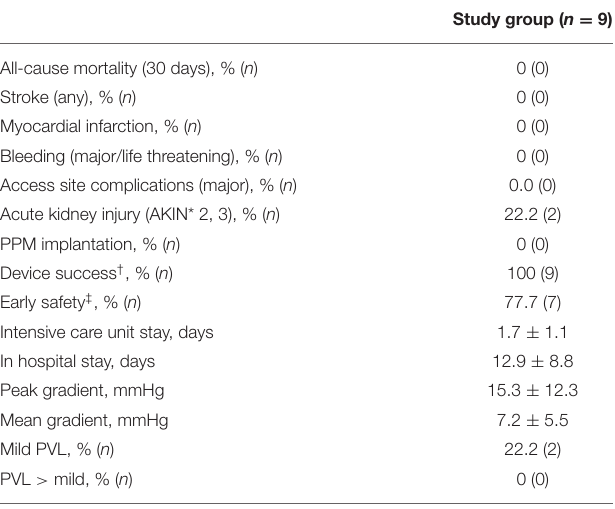
TABLE 4 | Clinical outcome and echocardiographic results at 30 days.